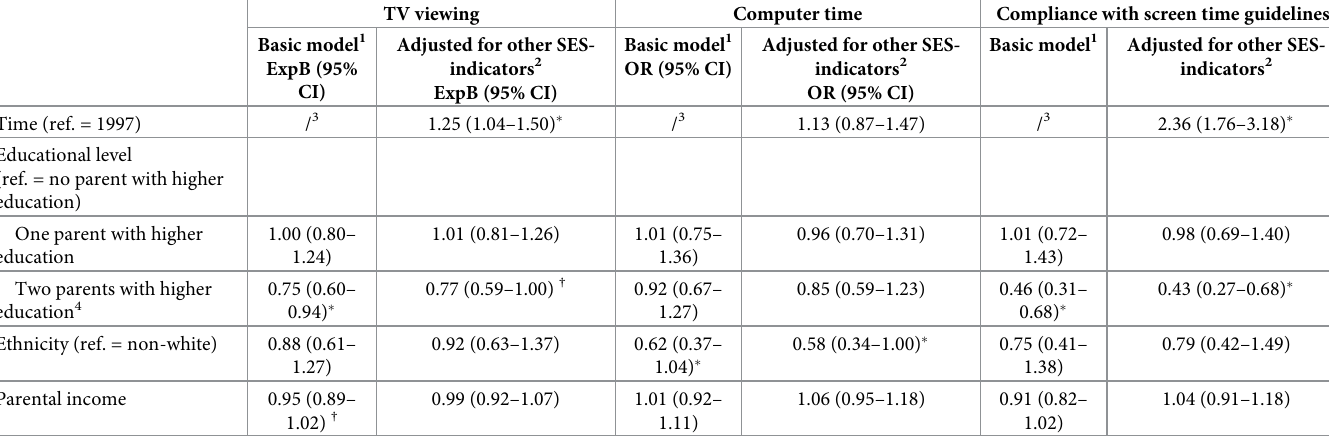
Table 2. Evolution in TV viewing or computer time according to educational level, ethnicity and parental